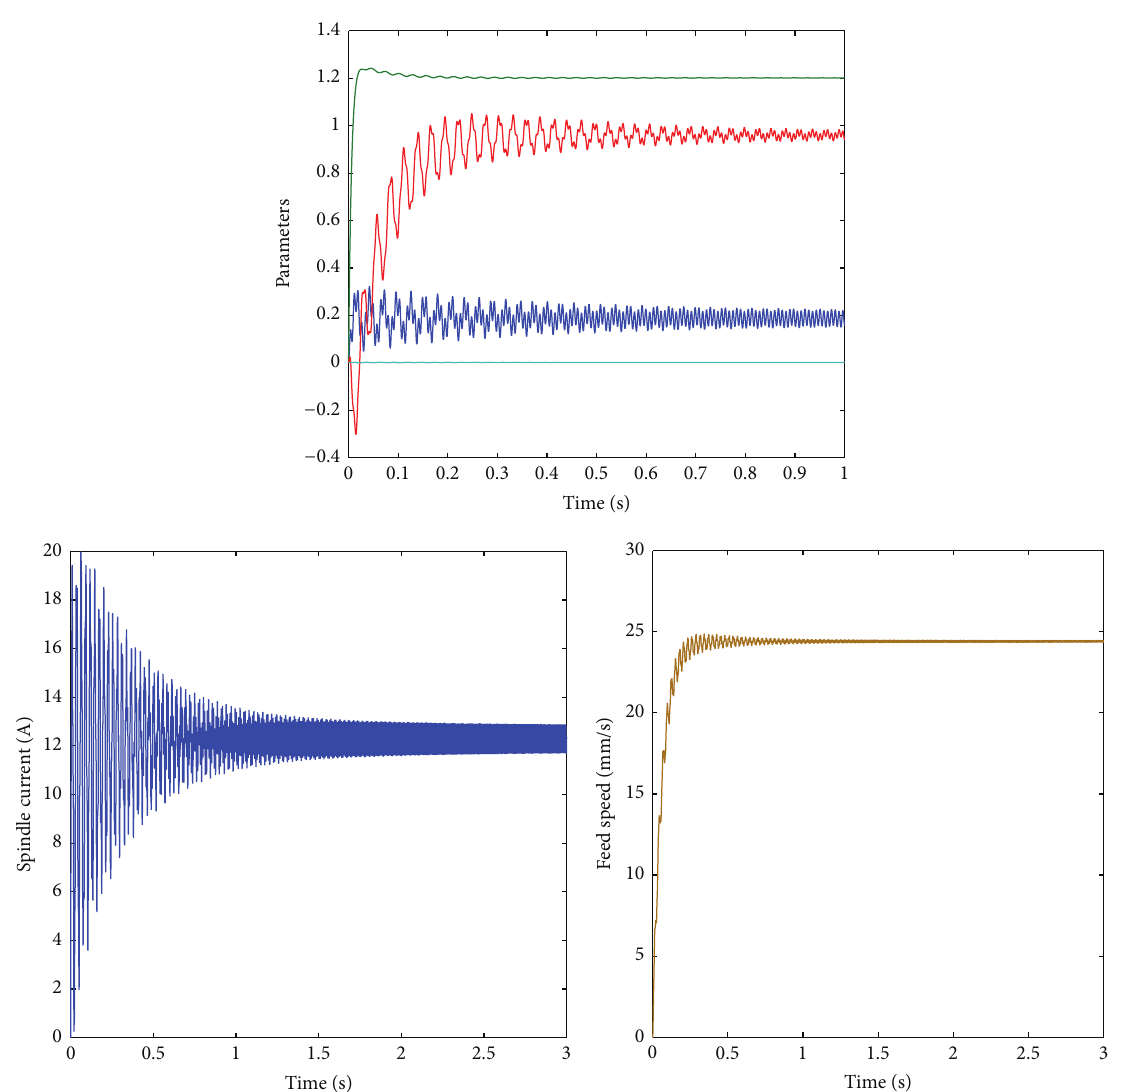
Figure 4: The simulation curve of spindle and 𝑥 -axis CNC machining